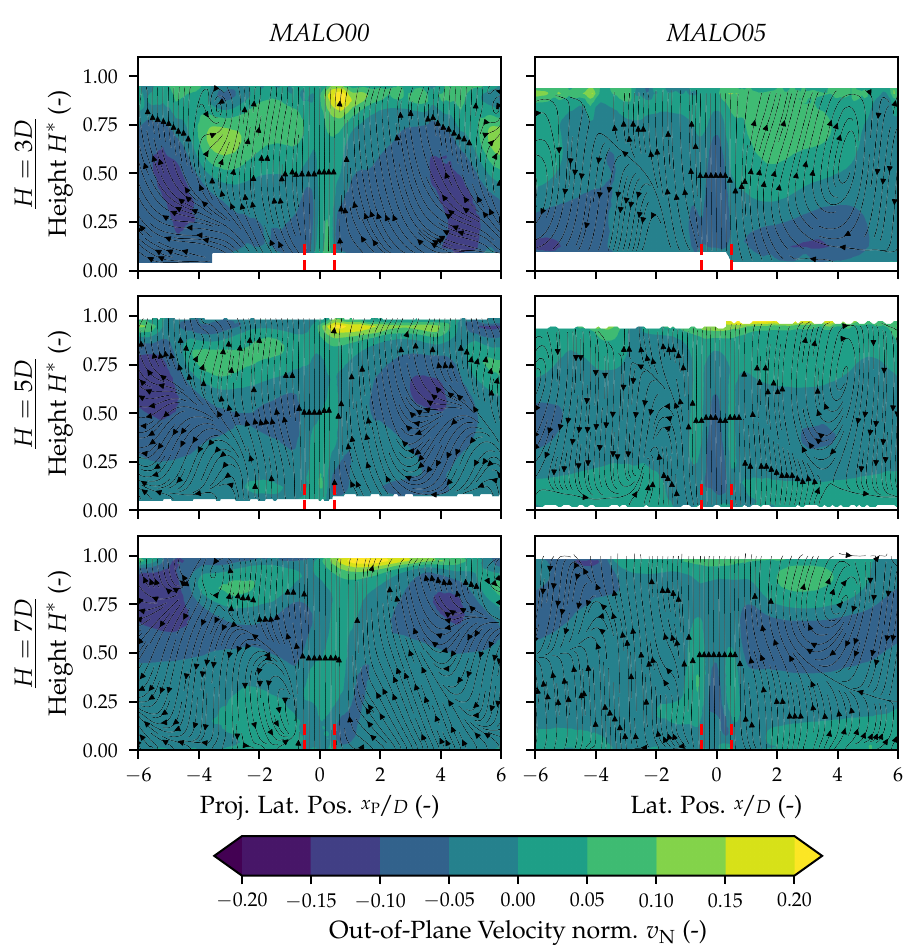
Figure 7. Cavity flow, low Reynolds number Re D ≈ 10 × 10 3 . Planar cut data for the plane intersect- ing the impinging jet and the closest effusion hole, e.g., ≈ 45° angle for MALO00 and y -normal for MALO05 . Streamlines show in plane velocity, contours out of plane velocity. All velocities normalized with in-plane velocity magnitude. Impingement hole location shown in